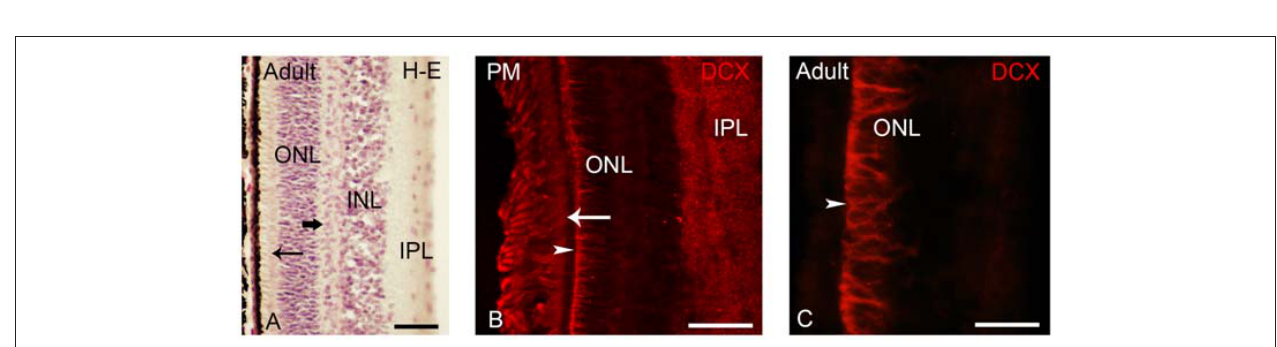
FIGURE 6 | (A) Photomicrograph of a transverse section of the adult lamprey retina stained with H-E. The thick arrow points to horizontal cells in the outer part of the INL. The thin arrow points to photoreceptors. (B,C) Retinas of postmetamorphic (B) and upstream migrating (A,C) adults showing DCX immunoreactivity. In young postmetamorphic retinas (B) DCX immunoreactivity was observed in the outer segments of photoreceptors (thin arrow), in fibers in the IPL and in radial fibers of the ONL ending in the OLM (marked by an arrowhead). In upstream migrating adults DCX immunoreactivity was only observed in radial fibers coursing in the ONL and ending in the OLM (C) . In all larval photomicrographs, dorsal is up and medial is to the left. Scale bars: 25 µ m in (A) ; 50 µ m in (C) ; 75 µ m in (B)